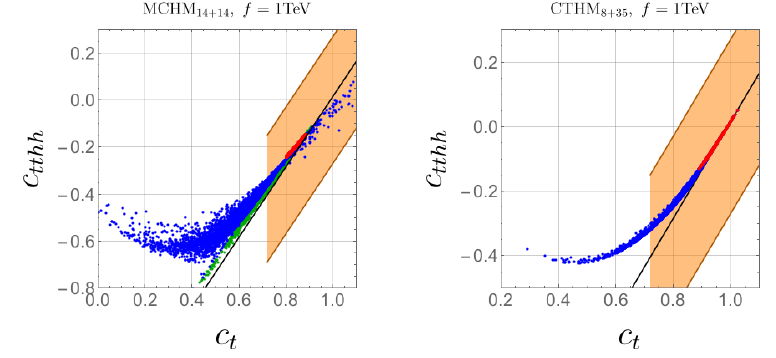
Figure 12 . The distribution of c tthh vs c t in models with high dimensional representations. The scale f is set to 1 TeV. In the MCHM, the green points predict c t > c g thus the model has the problem of triggering EWSB [50], while the blue points satisfy c g > c t . EWSB is automatically triggered in CTHMs. The black line represents the relationship between c t and c tthh in eq. (6.2). The orange block represents the relation of eq. (6.3) with c W and c t within 2 (cid:27) uncertainties from current Higgs signals [67]. The red dots are within the 3 (cid:27) region of global (cid:12)t as shown in (cid:12)gure